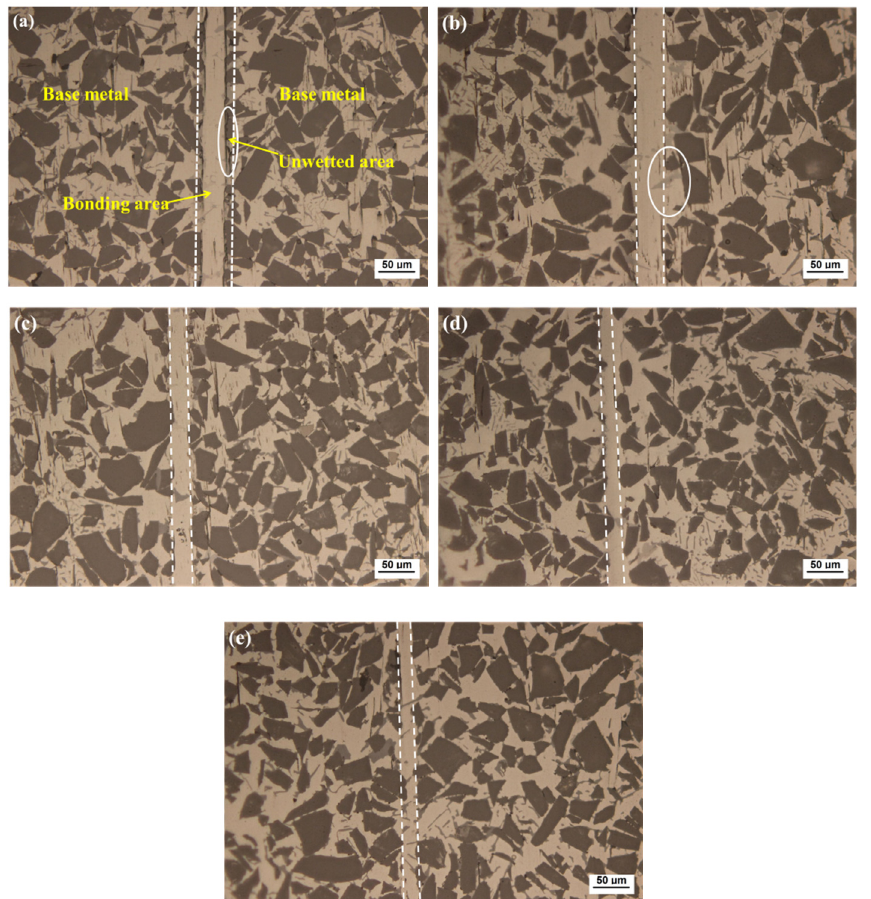
Figure 9. Optical microstructure of joints brazed at different temperatures: ( a ) 560 °C; ( b ) 570 °C; ( c ) 580 °C; ( d ) 590 °C; ( e ) 600 °C.